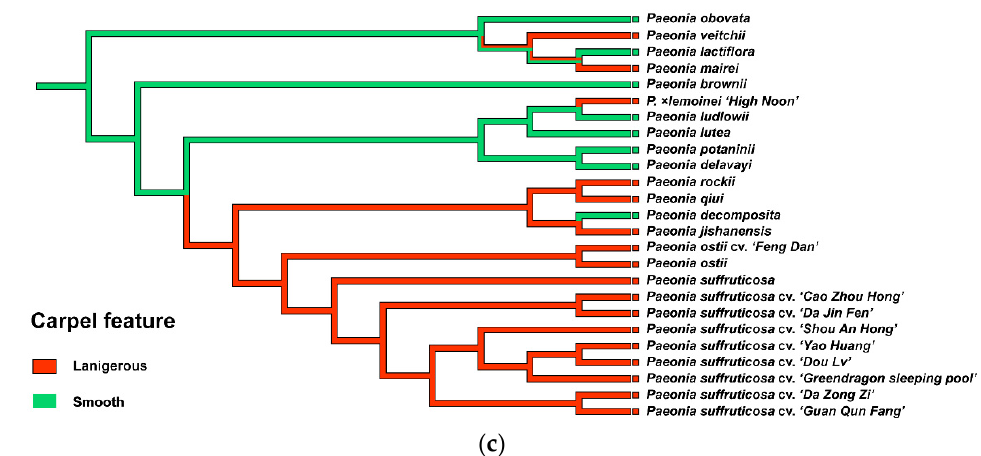
Figure 5. Reconstruction of ancestral characteristics in the context of the topology in Figure 2. The color in the square represents the specific characteristics of this morphological trait in the species (cultivars). The colors of different nodes in the topology represent the inference results of the corresponding ancestral characteristics based on the morphological characteristics of the species (cultivars) and the topology of Figure 2. (The other six reconstruction results of the ancestral characteristics of Paeoniaceae based on morphological features and topological structure are located in Supplementary Figures S17–S22). ( a ) Reconstruction of ancestral petal round numbers in the context of the topology in Figure 2; ( b ) Reconstruction of ancestral receptacle shape in the context of the topology in Figure 2; ( c ) Reconstruction of the ancestral carpel feature in the context of the topology in Figure